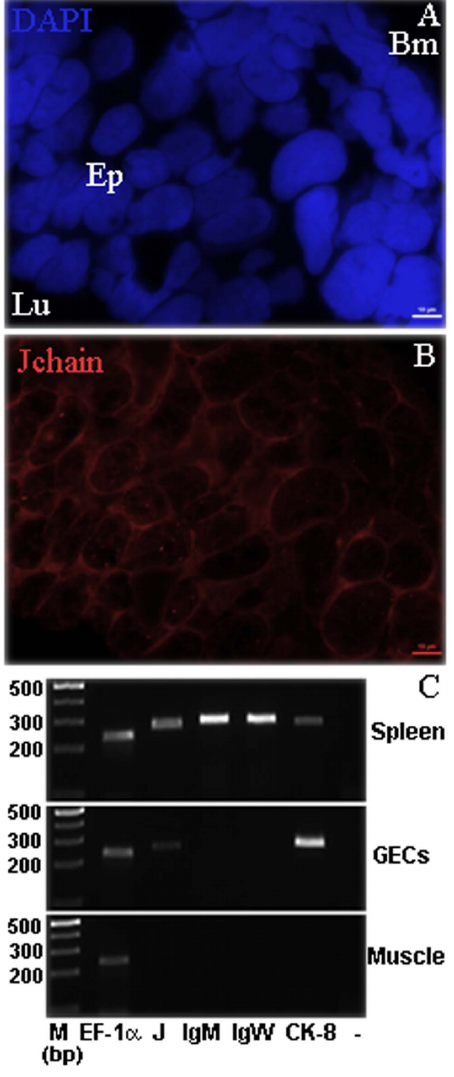
Figure 6. P.dolloi gut epithelial cells (GEC) express J chain. A) P. dolloi gut cryosection stained with the nuclear stain DAPI (blue) showing the characteristic nuclear morphology of epithelial cells B) P. dolloi gut cryosection stained with Cy-3 J chain Stellaris FISH probe. Epithelial cells contained numerous J chain transcripts (dots). Ep: epithelial cells, Lu: lumen, Bm: basal membrane C) Gut epithelial cells were dissected from control P. dolloi gut cryosections using LCM. Total RNA from P. dolloi pre-pyloric spleen, LCM gut epithelial cells (GEC) and muscle was extracted and used as template for RT-PCR using J chain (J), IgM, IgW and cytokeratin 8 (CK-8) specific primers. EF-1 a served as cDNA control. ‘‘–’’ indicates J chain negative control. M (marker) indicates the DNA ladder. The sequences of all PCR products were confirmed by cloning and sequencing.